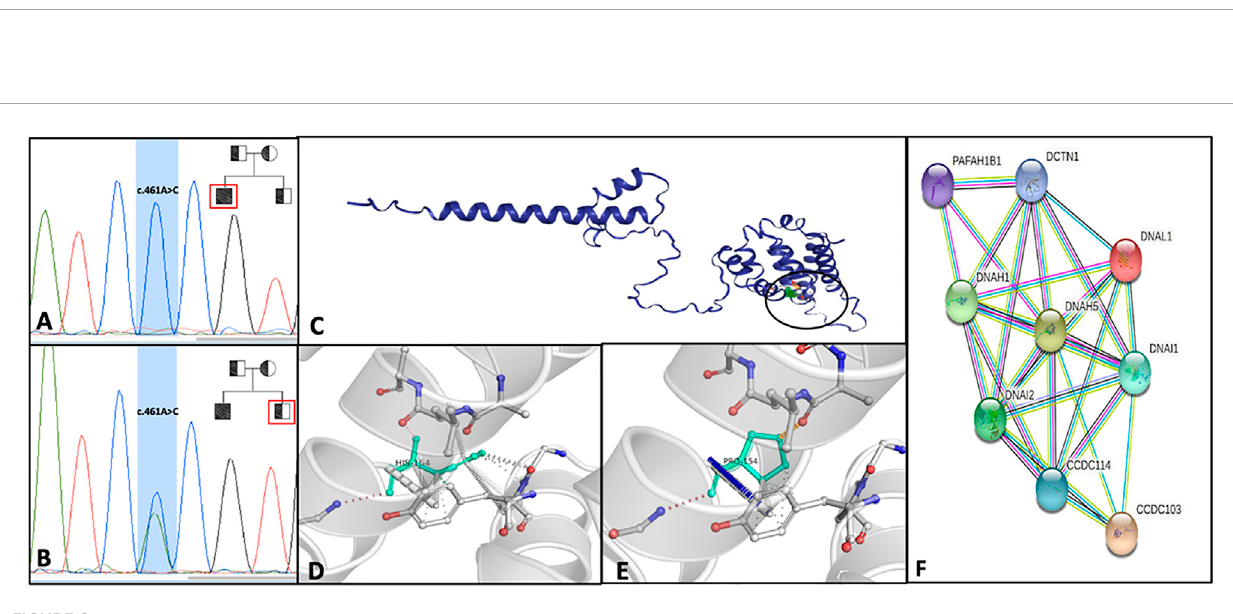
FIGURE 2 Electropherogramsofthepatientswithccdc103c.461A > Cmutationinhomozygous (A) andhisheterozygotebrother (B) ;intherightcornerofImagesA andB,thefamilypedigreeisshown.Squaresandcirclesrepresent,respectively,malesandfemales.Filledsymbolrepresentstheaffectedmember,andslashed symbols represent deceased members. (C) DynaMut prediction of interactomic interaction of CCDC103. Wild-type (D) and mutant H154P (E) residues are colored in light green and represented as sticks alongside the surrounding residues involved in any interactions. (F) STRING analysis summarizing functional information about ccdc103 with respect to the biological process, gene ontology category and predicting possible associations among them. STRING networks consist of nodes (spheres) representing proteins, while edges represent the predicted mode of action among